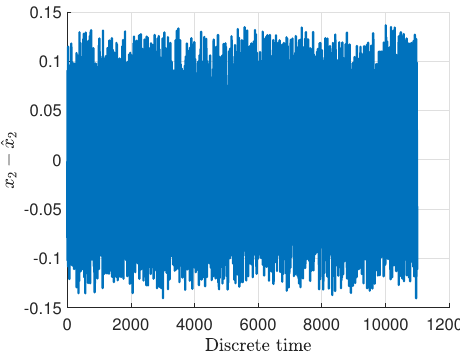
Figure 8. Evolution of the state estimation error for the pitch angle of the